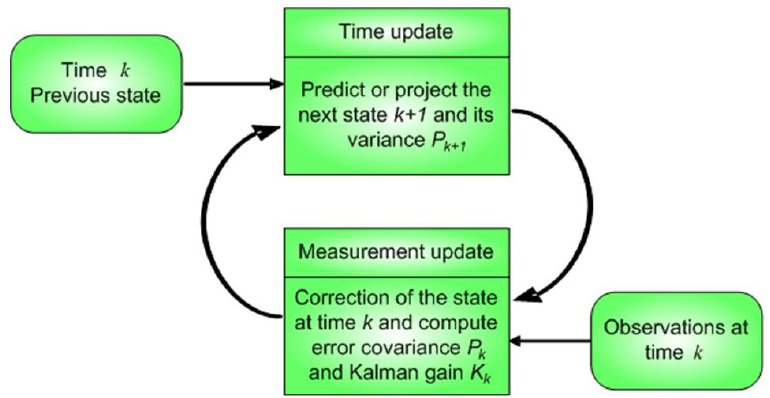
Figure 11. Simplified flow diagram for Kalman filter.